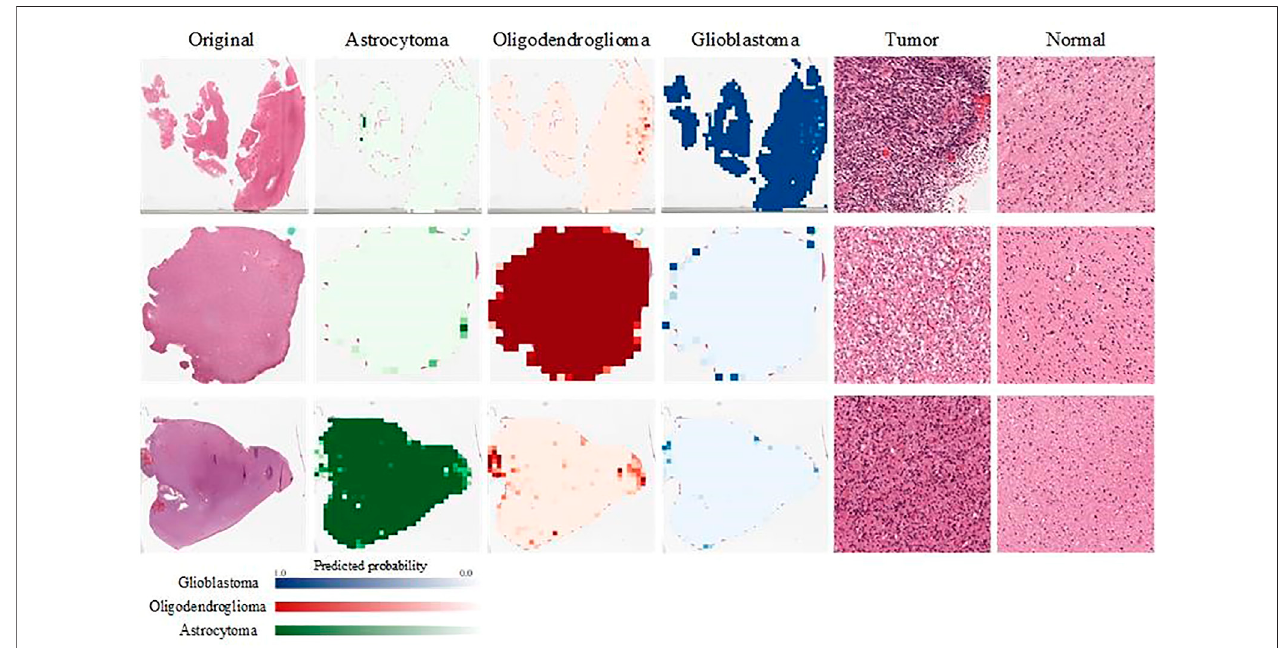
FIGURE5| Visualizationoftheprobabilitiesoftheoutputresults.WeevaluatetheprobabilitythateachpatchbelongstoA/O/G.GreenrepresentsA,redrepresents O, and blue represents G. In addition, we show the patches of different glioma subtypes and normal tissues separately.